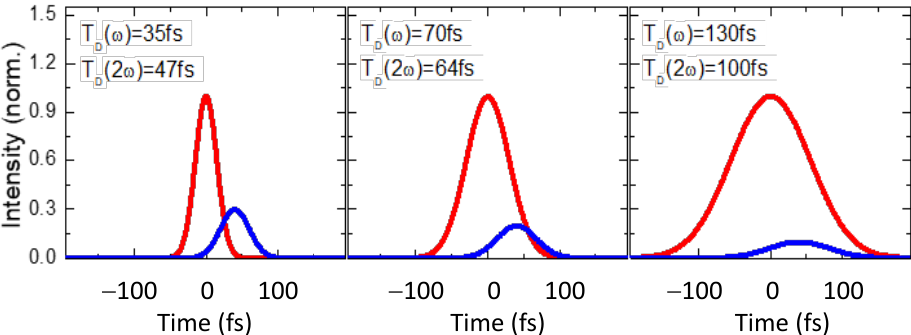
Figure 3. The modeled broadening of pulses and the relative time positions of SH pulses (blue curve) compared with the fundamental pulses (red curves) after passing through the 0.2 mm thick BBO crystal. The intensity of SH is increased with a factor of 4 for better visibility. T D ( ω ) and T D (2 ω ) are the pulse durations for fundamental and SH pulses.